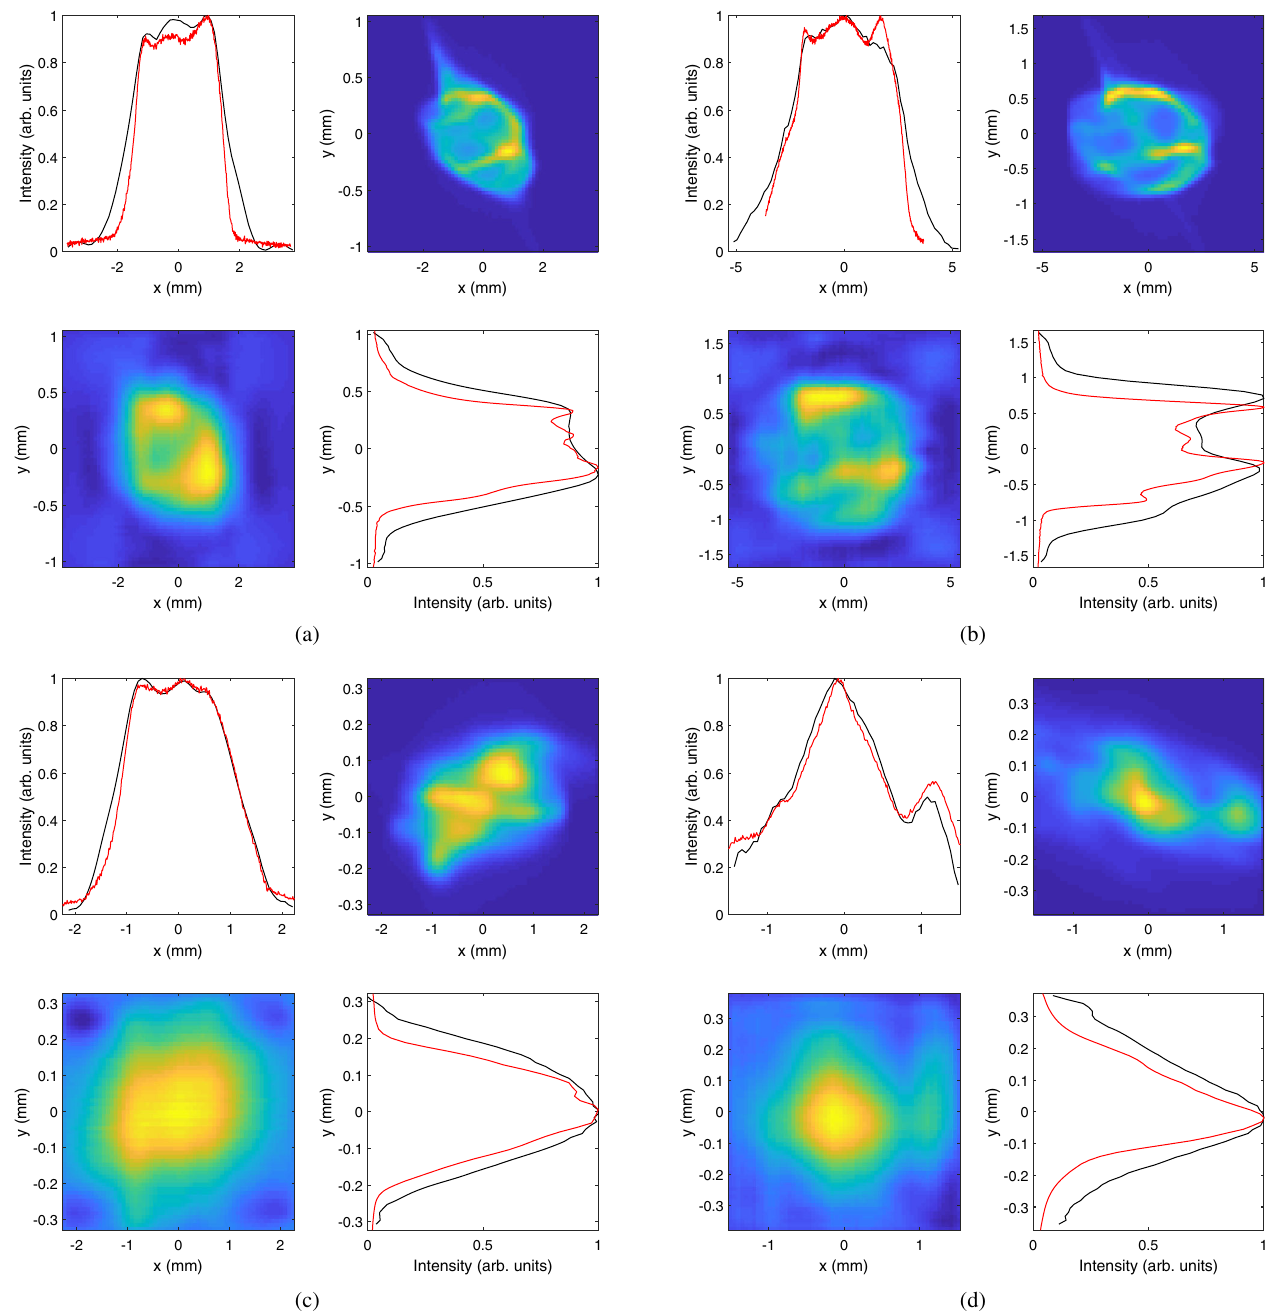
FIG. 9. Comparison between beam images observed directly at SCR-02 and the reconstruction of the images from phase space tomography in two degrees of freedom for a range of solenoid and bucking coil currents in the electron source and different bunch charges in CLARA FE. Within each subfigure, the plot at the top right shows the beam image observed directly on SCR-02; the plot at bottom left shows the charge distribution in coordinate space reconstructed from phase space tomography (a projection of the four- dimensional phase space onto the coordinate plane) at the same location. The plots at top left and bottom right in each subfigure show the charge density projected onto the horizontal and vertical axes, respectively: black lines are from the tomography analysis and red lines are from the directly observed image. (a) Main solenoid − 125 A, bucking coil − 2.2 A, bunch charge 10 pC. (b) Main solenoid − 125 A, bucking coil − 2.2 A, bunch charge 20 pC. (c) Main solenoid − 150 A, bucking coil − 1.0 A, bunch charge 10 pC bunch charge 10 pC. (d) Main solenoid − 150 A, bucking coil − 5.0 A, bunch charge 10